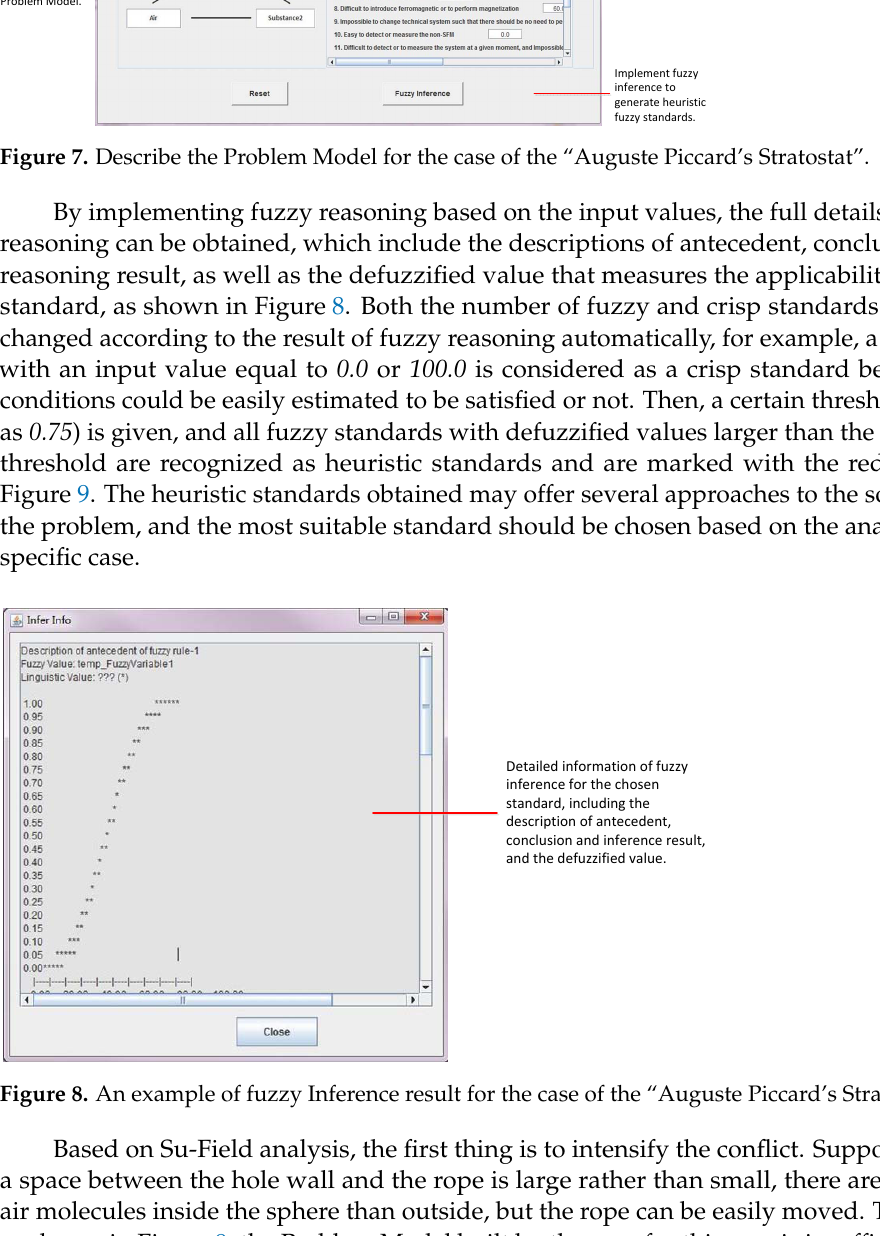
Figure 8. An example of fuzzy Inference result for the case of the “Auguste Piccard’s